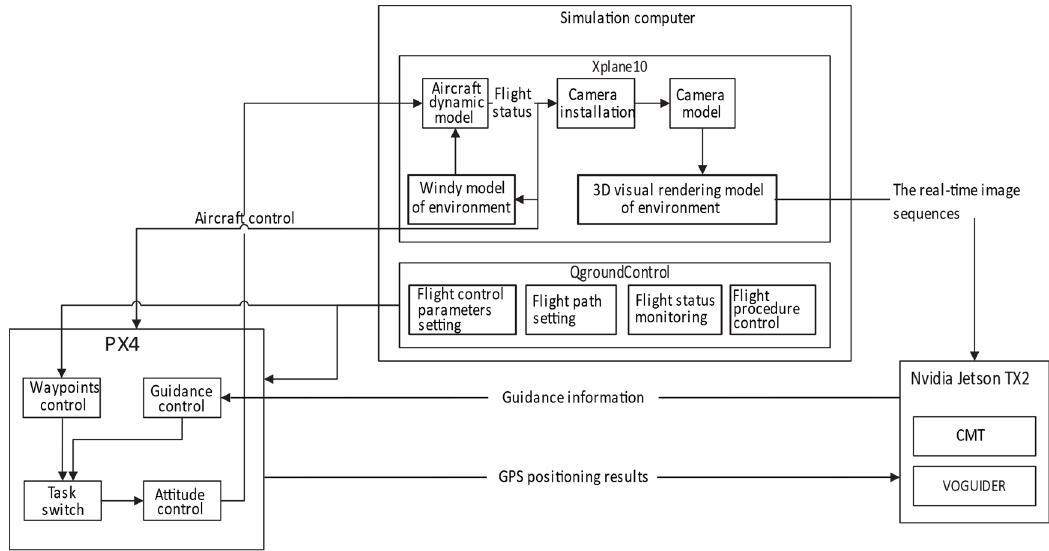
Figure 3. Block diagram of the working process of the simulation system.